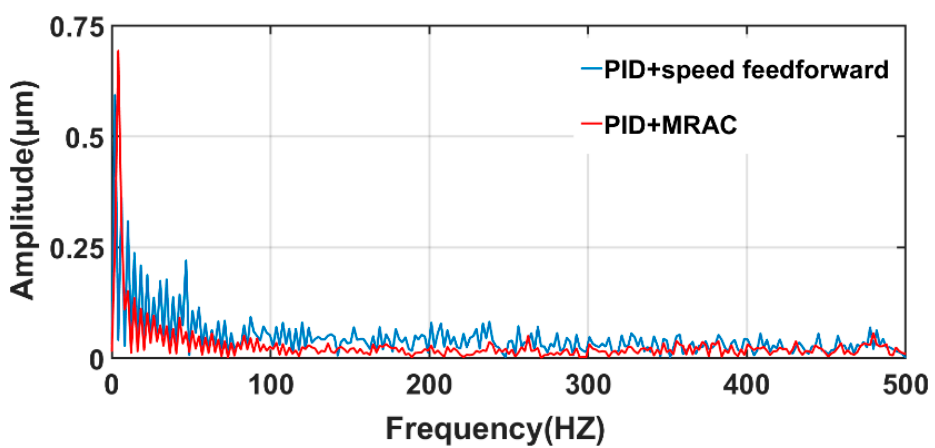
Figure 20. Frequency-spectrum analysis of following error.